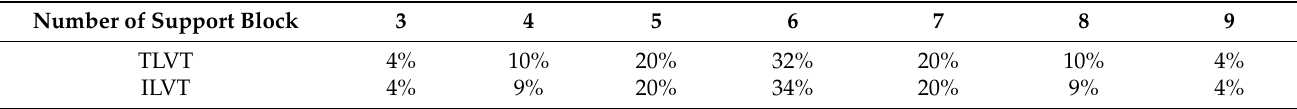
Table 1. The law of longitudinal sharing of vertical load.